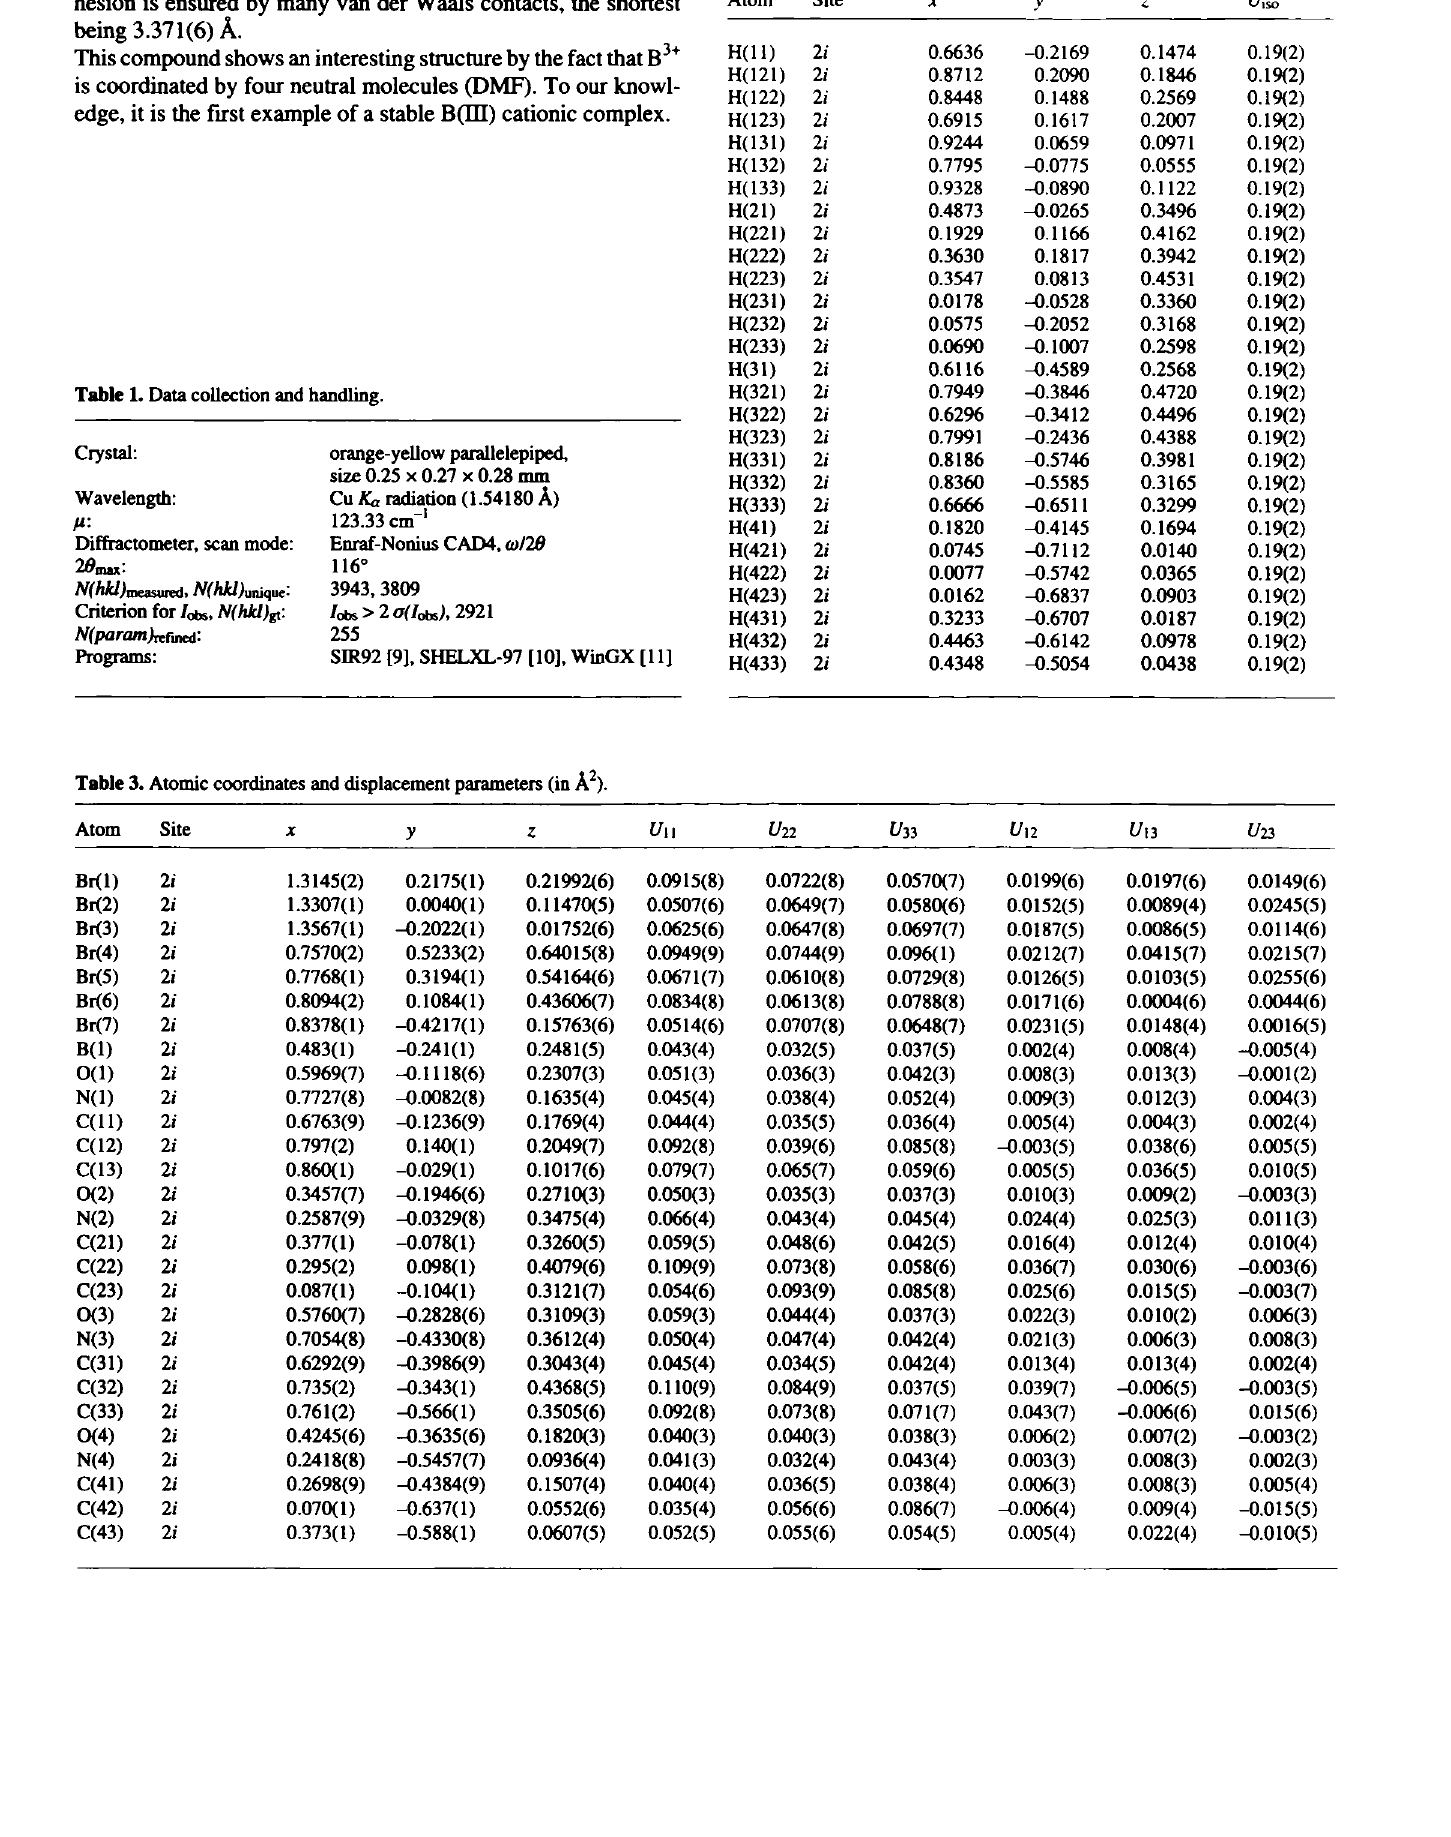
Table 2. Atomic coordinates and displacement parameters (in Â 2 ).